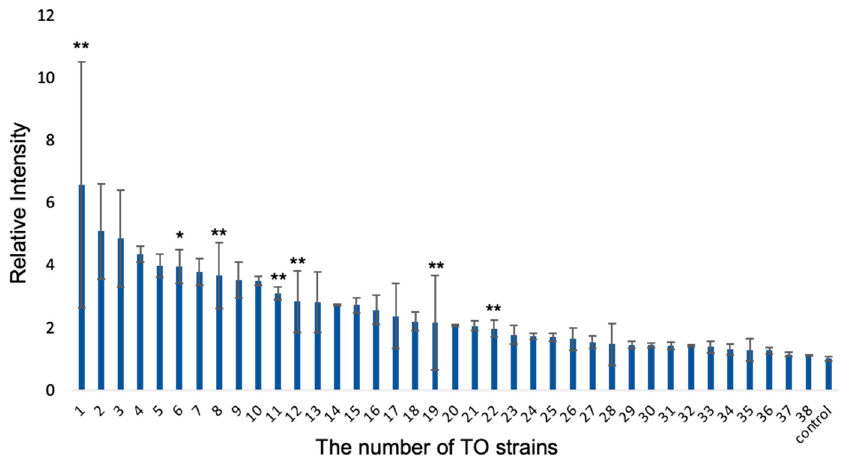
Figure 2. Relative chemiluminescence intensity by luminol reaction for 38 strains in the TO library named in descending order of iron elution from TO1 to TO38. TO1 showed the highest contribution to iron elution. (Mean ± SD, n = 3). (Dunnett’s test, * p < 0.05, ** p < 0.01).